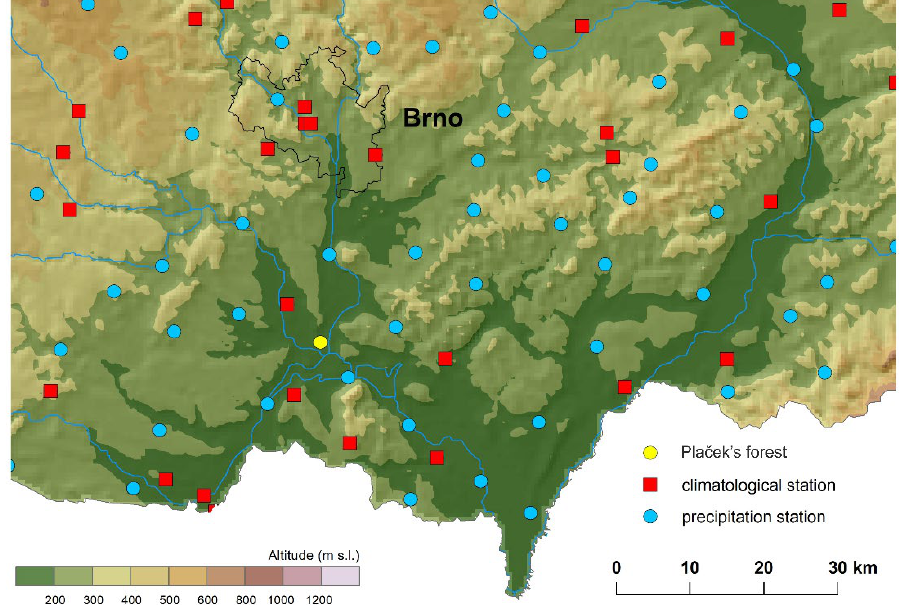
Figure 2. Location of climatological and precipitation stations series used for interpolation.